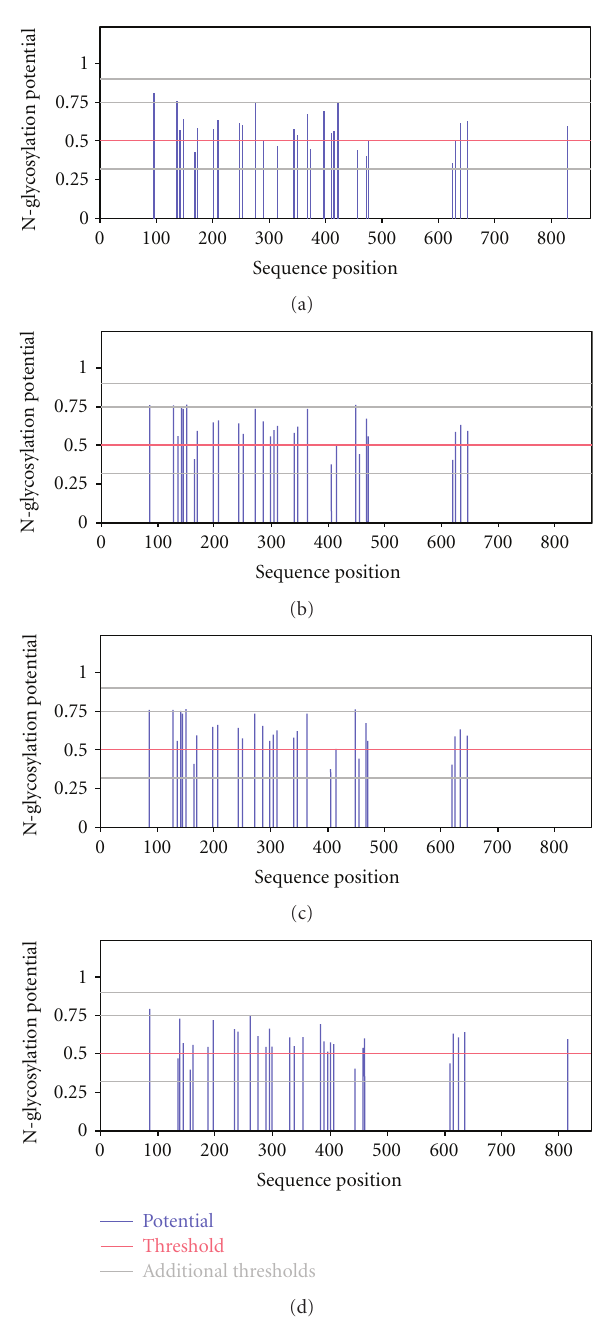
Figure 2: Potential N-glycosylation sites predicted from SignalP- NN. (a) Group I (1990–1994). (b) Group II (1995–1999). (c) Group IV (2005–2007). (d) Group IV